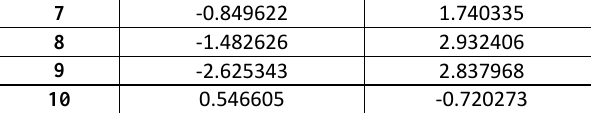
Table 5. Residuals for 1 st order Polynomial Transformation